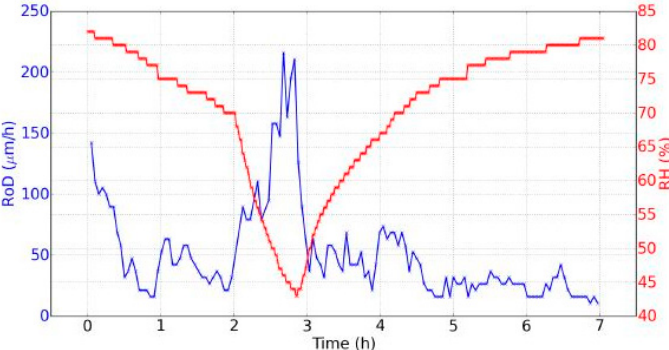
Figure 10. Evolution of the RH and the RoD during seven hours (day 2, one point every minute for the RH, and one point every three minutes for the RoD).